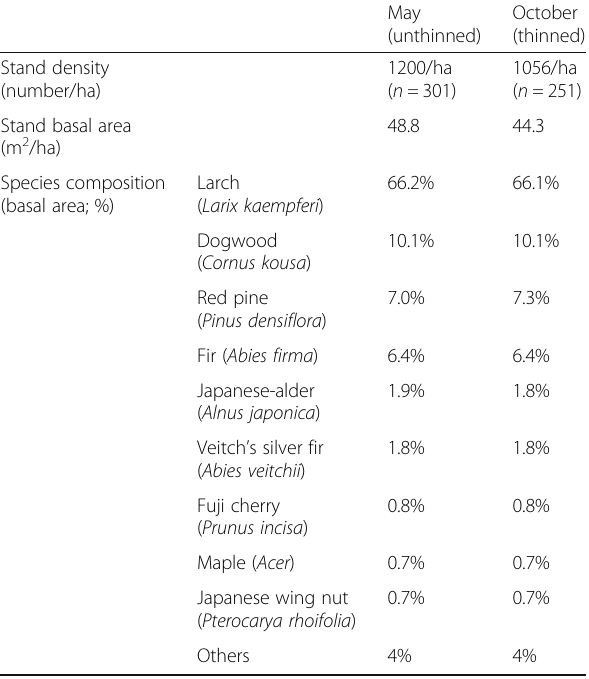
Table 2 Species data for May and